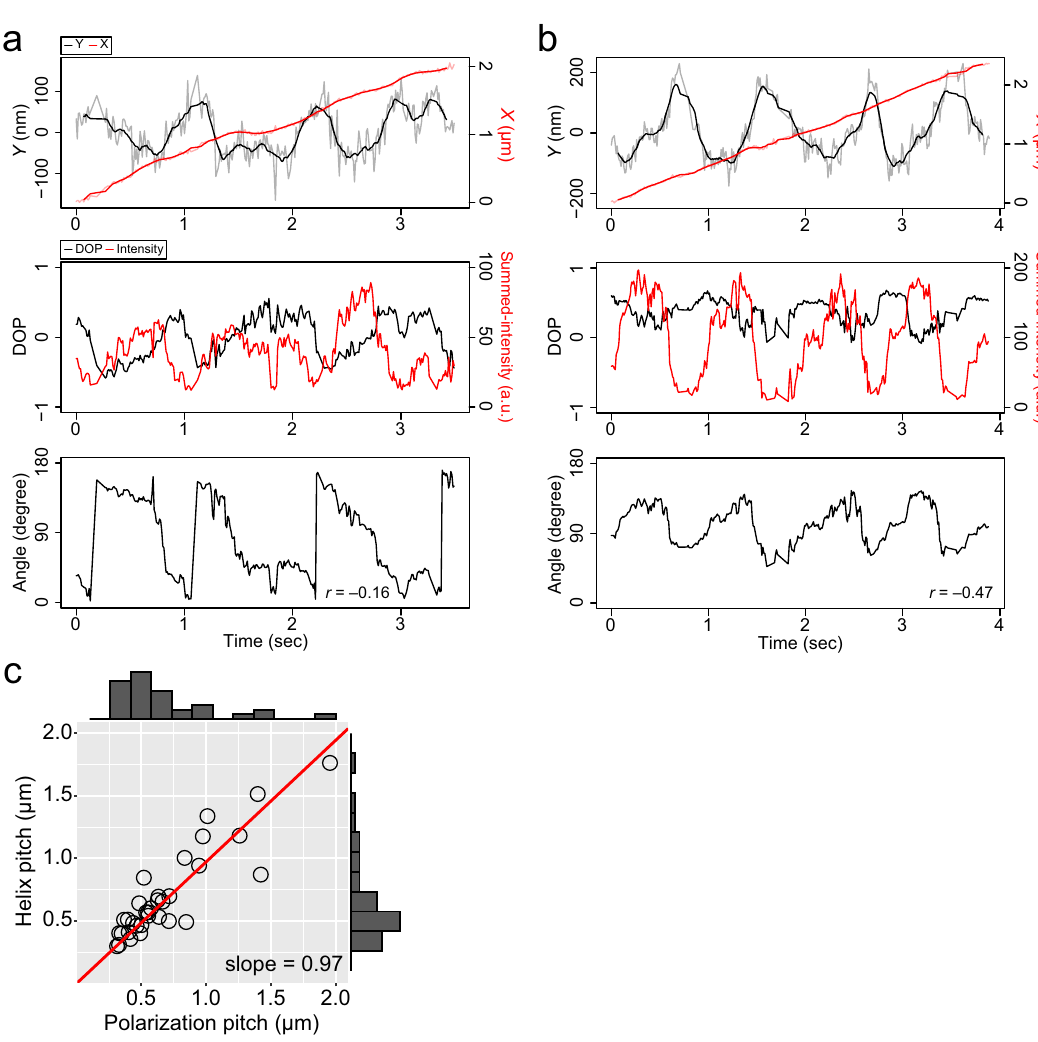
Fig. 3 Coupled polarization rotation and helical motion of KIF1A-GNRs. a , b The time trajectories of the X (red line)- and Y (black line)-displacements, the degree of polarization (DOP, black line) and summed-intensities (red line) of the two spots, and the estimated angles of KIF1A-GNRs. The time trajectories of the polarization in the image plane show clockwise rotation ( a ) and oscillatory rotation ( b ). The value of r is Pearson ’ s correlation coef fi cient between the Y -displacement and the angle. c Distribution of the helix and polarization pitches of KIF1A-GNRs. The helix and polarization pitches are the displacements during one periodic change in the Y -displacement and the polarization, respectively. The red line represents a linear fi t ( y = ax ) of which the slope ( a ) is 0.97 ( R 2 =